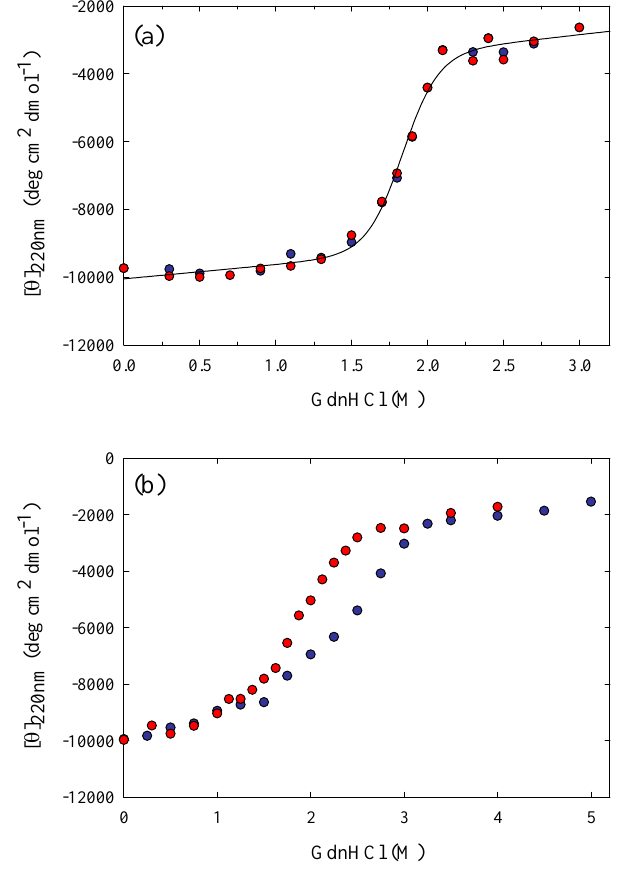
Figure 3. GdnHCl-induced unfolding (blue circles) and refolding (red circles) curves of Tk-RNase HII at (a) 50 °C for two weeks and (b) 20 °C for one month, monitored by measuring CD at 220nm. The solid line in (a) is the best fit to a two-state equation. For unfolding, Tk-RNase HII was incubated in GdnHCl at different concentrations. For refolding, the protein, which was unfolded completely at a 4M GdnHCl concentration, was diluted with buffer and the diluted protein solution was incubated. Figures are reproduced from